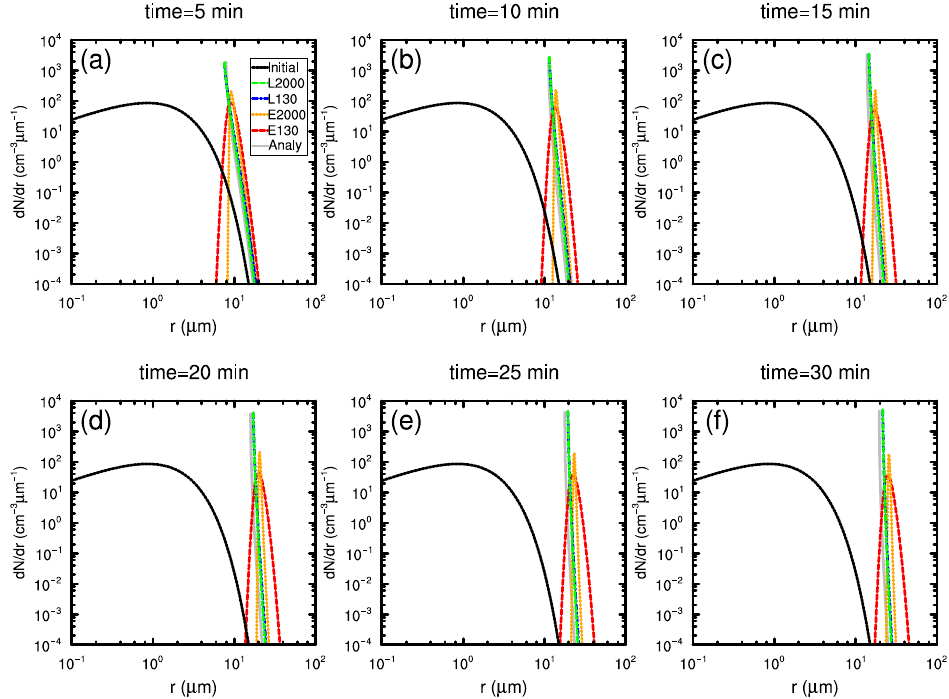
Figure 2. The time evolution of the droplet spectra in condensation growth from the analytical solution (Analy) and numerical solutions in the parcel cloud model: Eulerian advection scheme with 130 bins (E130), Eulerian advection scheme with 2000 bins (E2000), Lagrangian advection scheme with 130 bins (L130), Lagrangian advection scheme with 2000 bins (L2000), and the initial spectra (Initial). ( a ) Droplet spectra at 5 min. ( b ) Droplet spectra at 10 min. ( c ) Droplet spectra at 15 min. ( d ) Droplet spectra at 20 min. ( e ) Droplet spectra at 25 min. ( f ) Droplet spectra at 30 min.